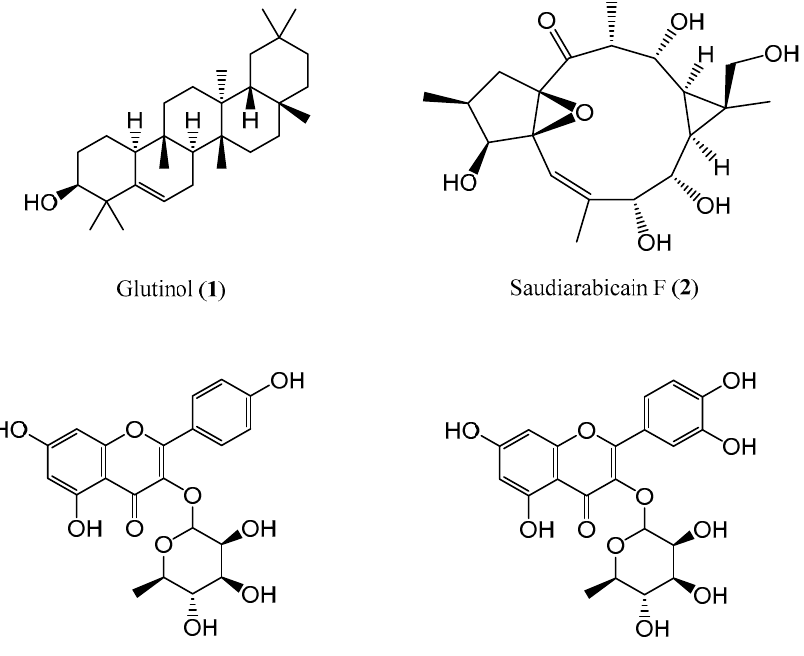
Figure 1. Chemical structures of phytochemicals isolated from Euphorbia saudiarabica aerial parts. The saudiarabicain F ( 2 ) was obtained as a white powder with the molecular formula C 20 H 30 O 7 , as determined by HR-ESI-MS ( m/z 382.1992), corresponding to fi ve degrees of unsaturation. The NMR data of compound 2 , when compared to the previously reported ingol-type diterpenoid, saudiarabicain E, revealed that the only di ff erence between these two compounds was the presence of hydroxy rather than benzyl and acetyl groups in C- 3, C-7, C-8, C-12 and C-19 [20]. Speci fi cally, the 13 C and 1 H NMR spectra revealed the pres-